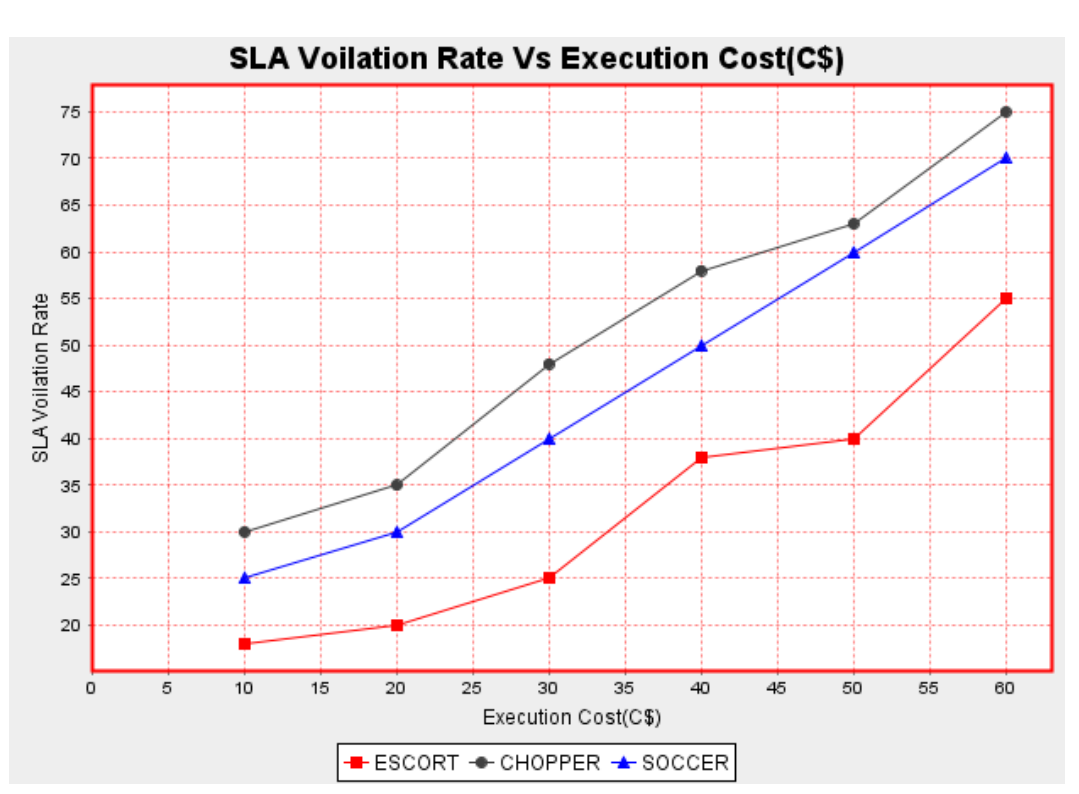
Figure 6. Execution cost